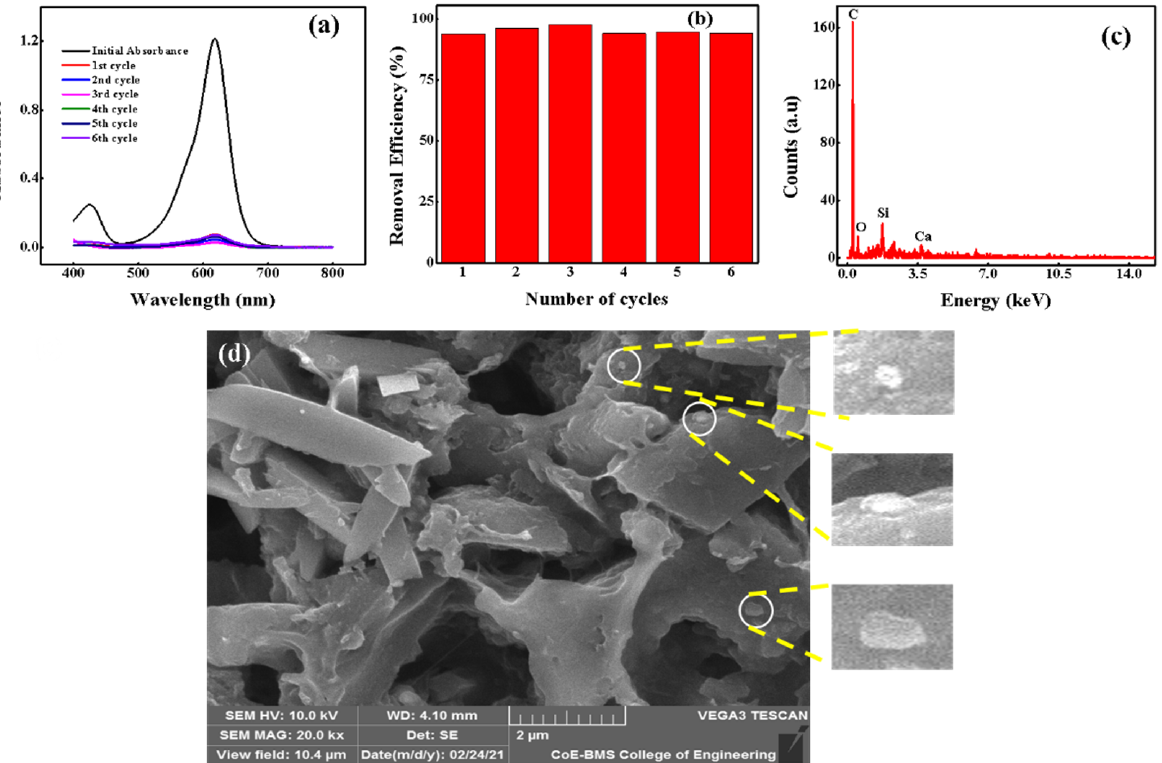
Figure 10. Reusability study of OPL-derived CNSs. ( a ) MG treated absorbance spectra in the reusa- bility study. ( b ) OPL based CNSs showing number of adsorption cycles. ( c ) EDS plot of reused CNSs. ( d ) SEM image of reused CNSs after several cycles.